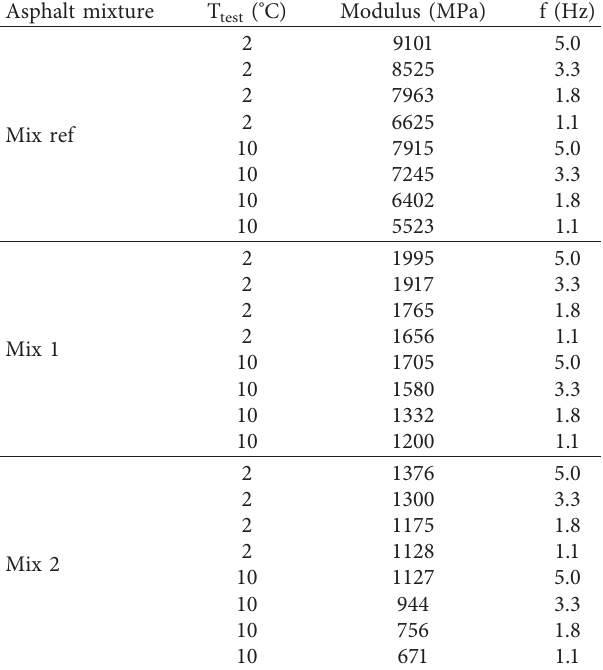
Table 4: Stiffness modulus of Mix ref, Mix 1, and Mix 2. Asphalt mixture